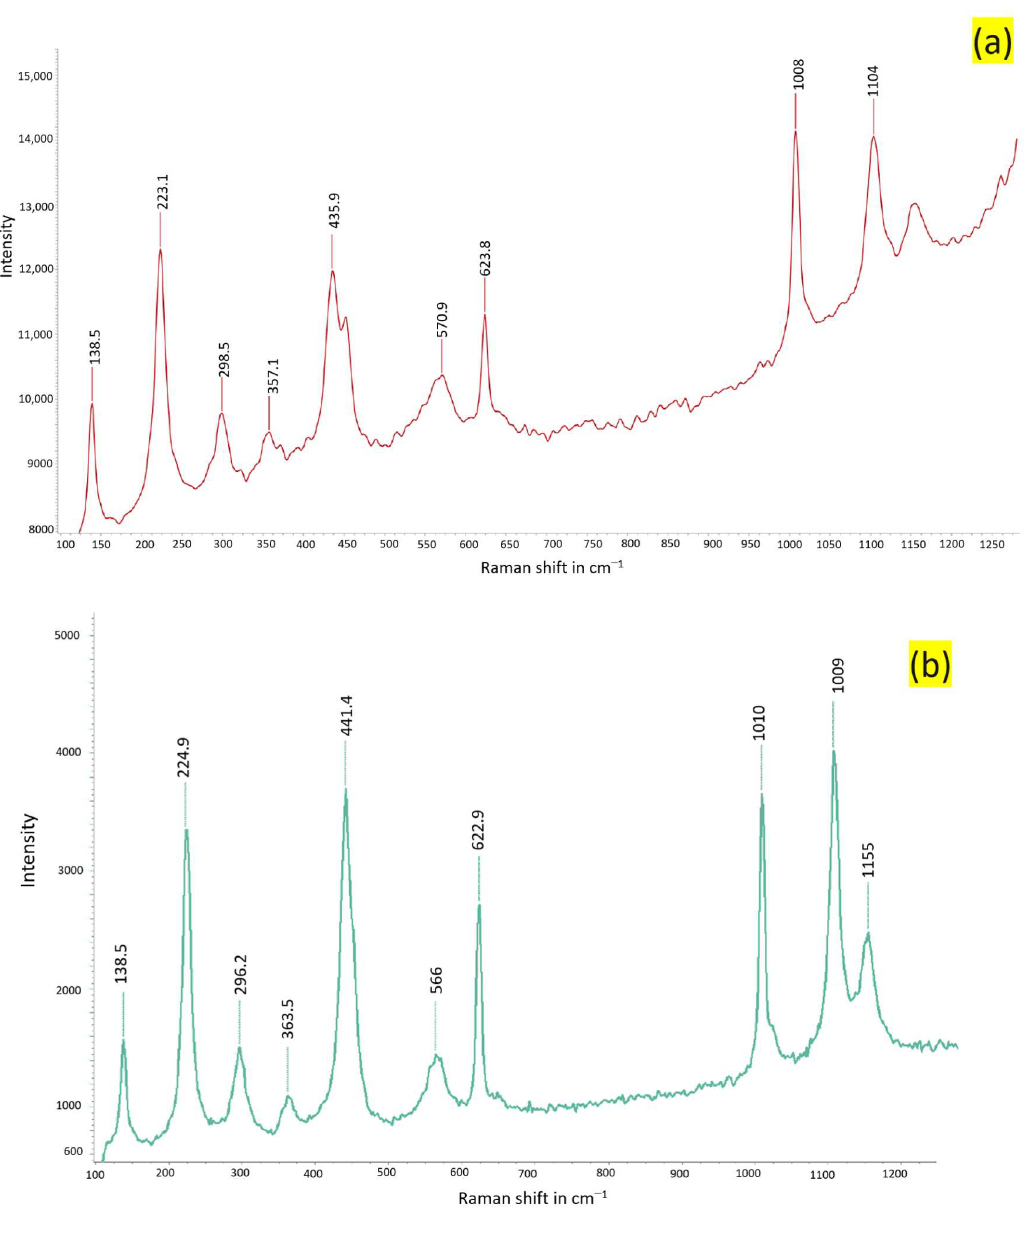
Figure 14. Raman spectra of samples acquired from Stefføya. The first one is composed more of jarosite ( a ) and the second likely contains more natrojarosite proportion ( b ). The peaks are similar. The strong bands between 1000 cm −1 and 1110 cm −1 are used for the distinctions.